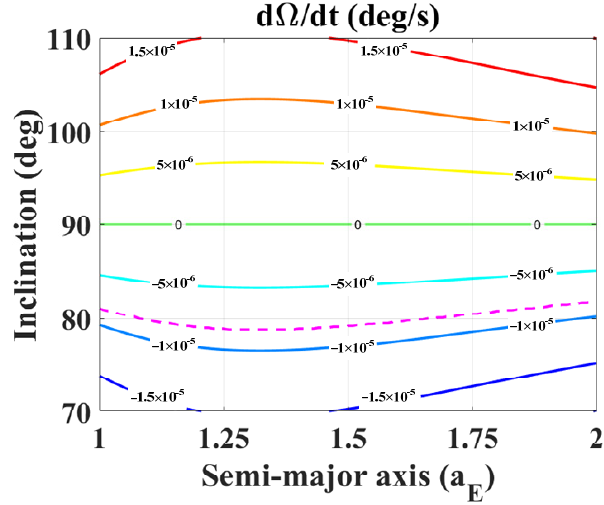
Figure 8. Rate of change of the longitude of the ascending node for a = 1.2 R E and e = 0.001.